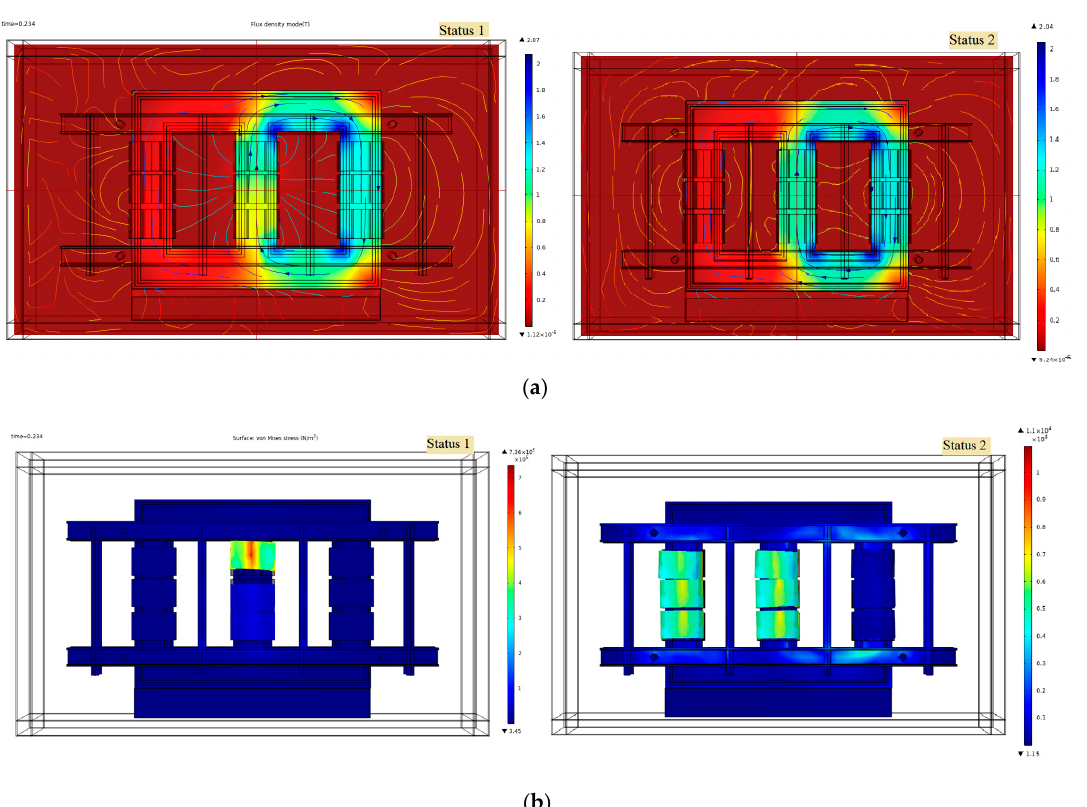
Figure 9. Multiphysical field simulation diagram for two states of the transformer. ( a ) Magnetic flux density diagram. ( b ) Stress distribution in a transformer fault condition.